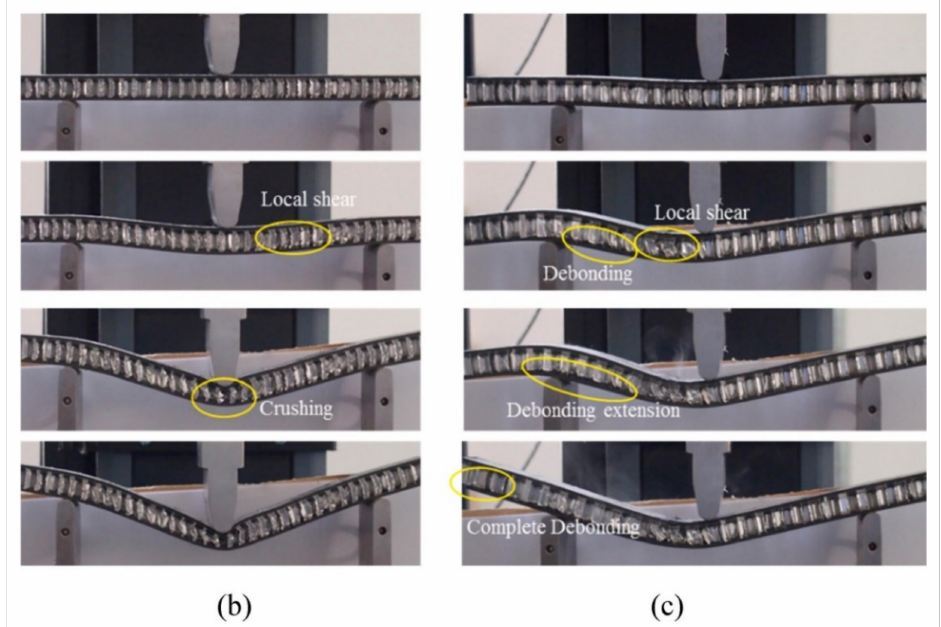
Figure 21. ( a ) Load displacement curve during three-point bending test; ( b , c ) Deformation mode of a sandwich specimen under three-point bending test